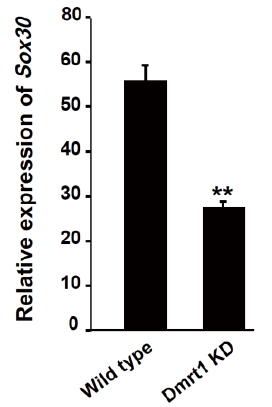
Figure 3. Change of Sox30 expression in the testes of Dmrt1 -deficient Nile tilapia. Sox30 expression was detected by quantitative RT-PCR in the testes of male Nile tilapia with Dmrt1 knockdown at 90 dah. KD, knockdown. The experiments were independently repeated three times. The data are presented as the means ± SE of the triplicates. **, p < 0.01, compared with the control.